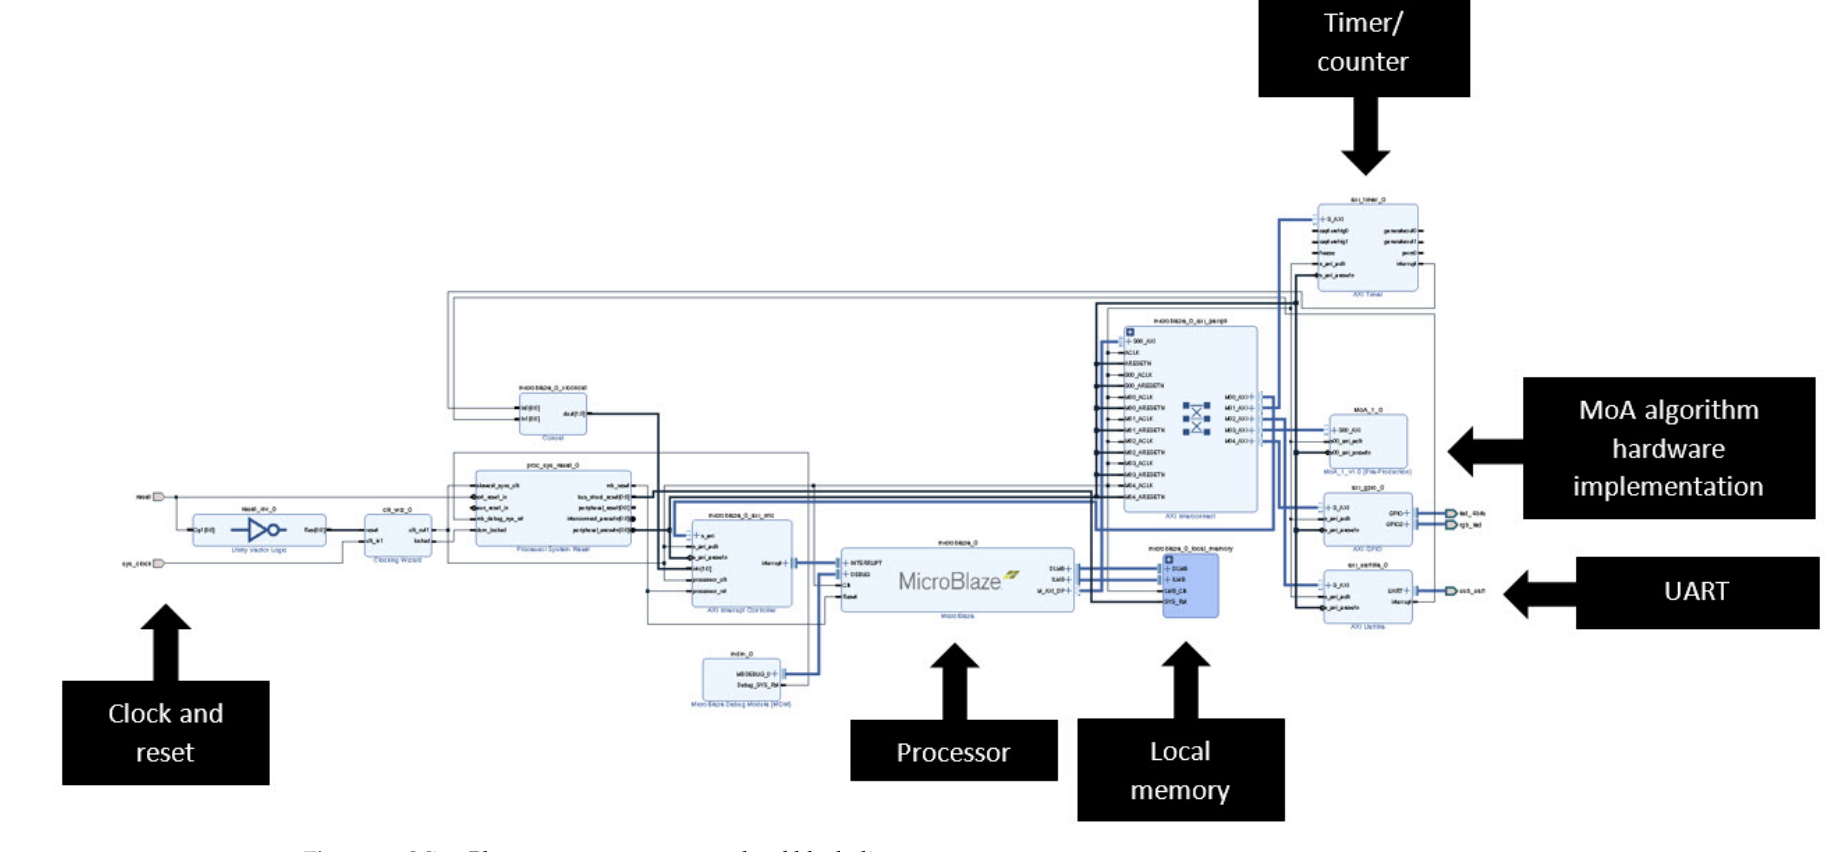
Figure 13. MicroBlaze processor system top level block